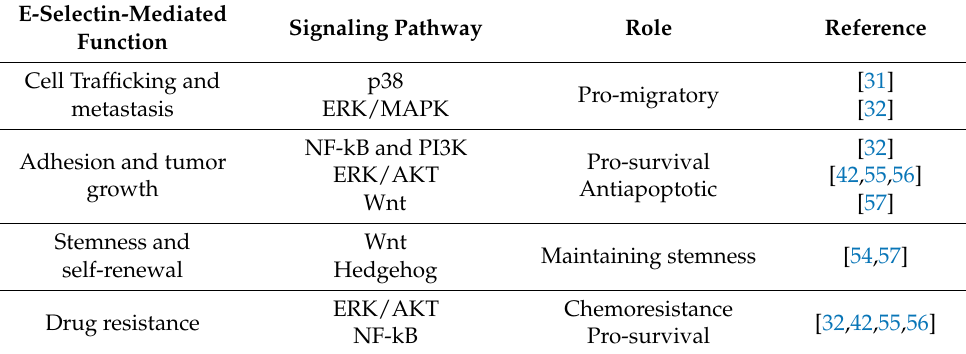
Table 2. E-selectin-mediated signaling